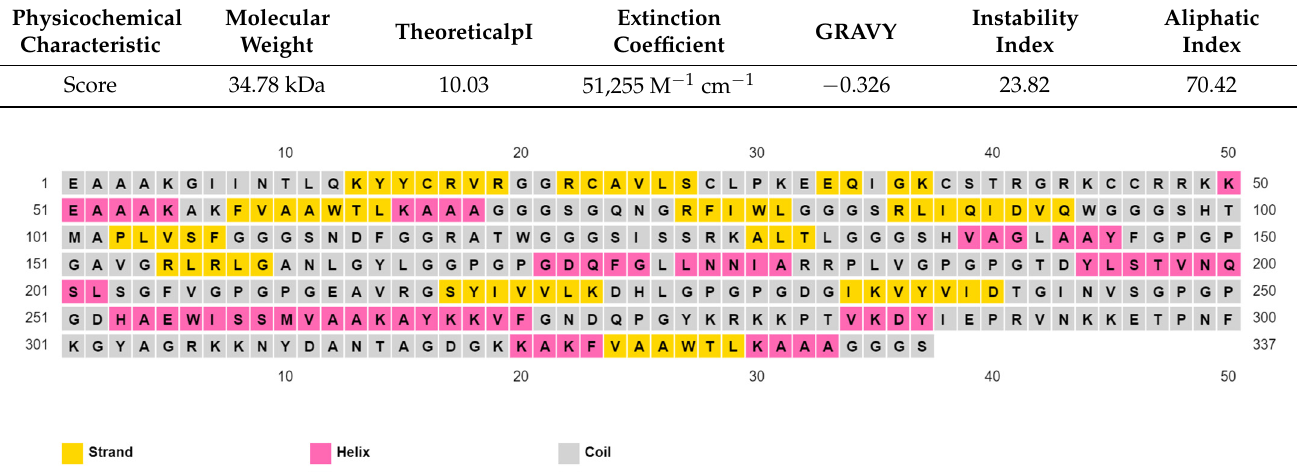
Table 7. Scores of the vaccine’s physicochemical characteristics assessment.